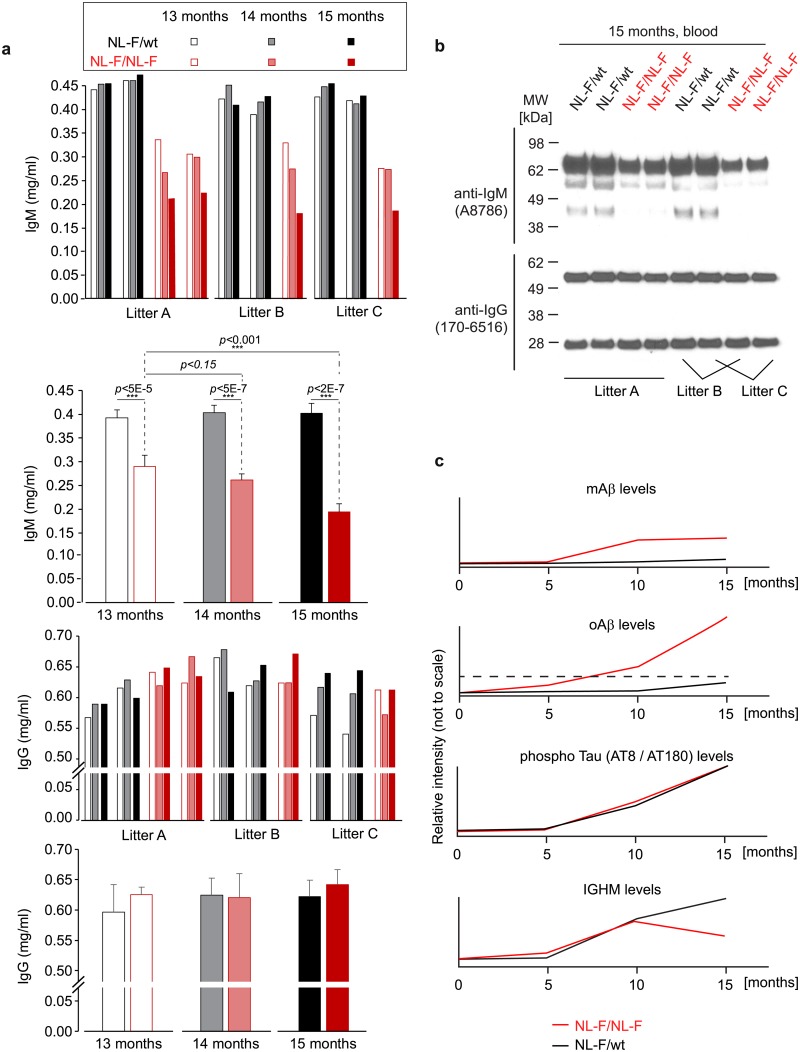
Depletion of IGHM in the blood is progressive and does not extend to immunoglobulin G.(a) Quantitative ELISA analyses of serum samples harvested from three mouse litters at three different time-points (i.e., at ages of 13, 14 and 15 months) established that the relative depletion of IGHM levels in APPNL-F/NL-F mice progressively increases in the time window investigated, and does not extend to immunoglobulin G (IgG) levels. Whenever p-values computed for relative ELISA signals passed significance thresholds, this was indicated in the graph, with triple (***) and single (*) asterisks designating p-values < 0.001 and <0.5, respectively. (b) Western blot analyses of a subset of serum samples utilized in panel ‘a’ further corroborated robust depletion of IGHM levels, but also revealed that IgG levels were not similarly depleted in direct comparisons of heterozygous APPNL-F/wt and homozygous APPNL-F/NL-F mice. (c) Schematic graphs summarizing the key trends in relative protein abundances observed in this study (not to scale).